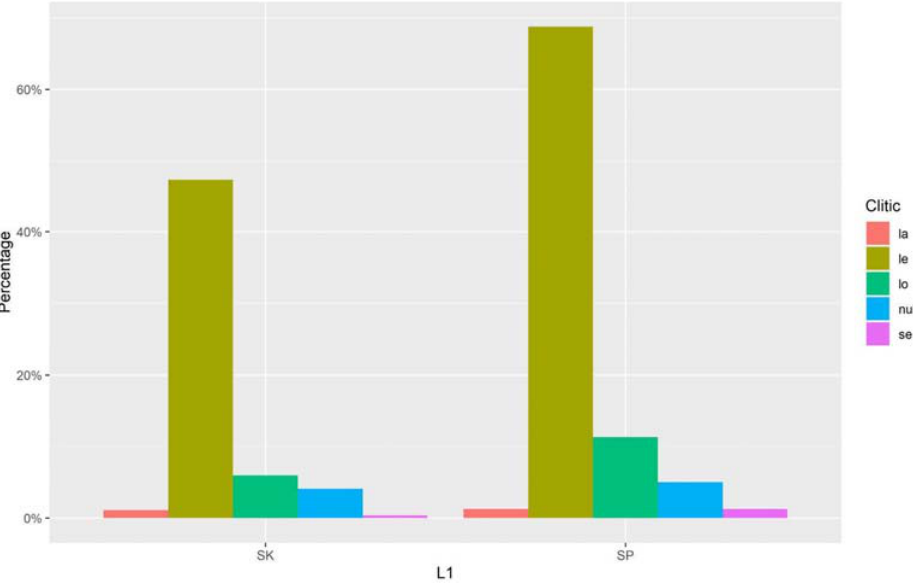
Figure 1. Distribution of clitics by L1 background.